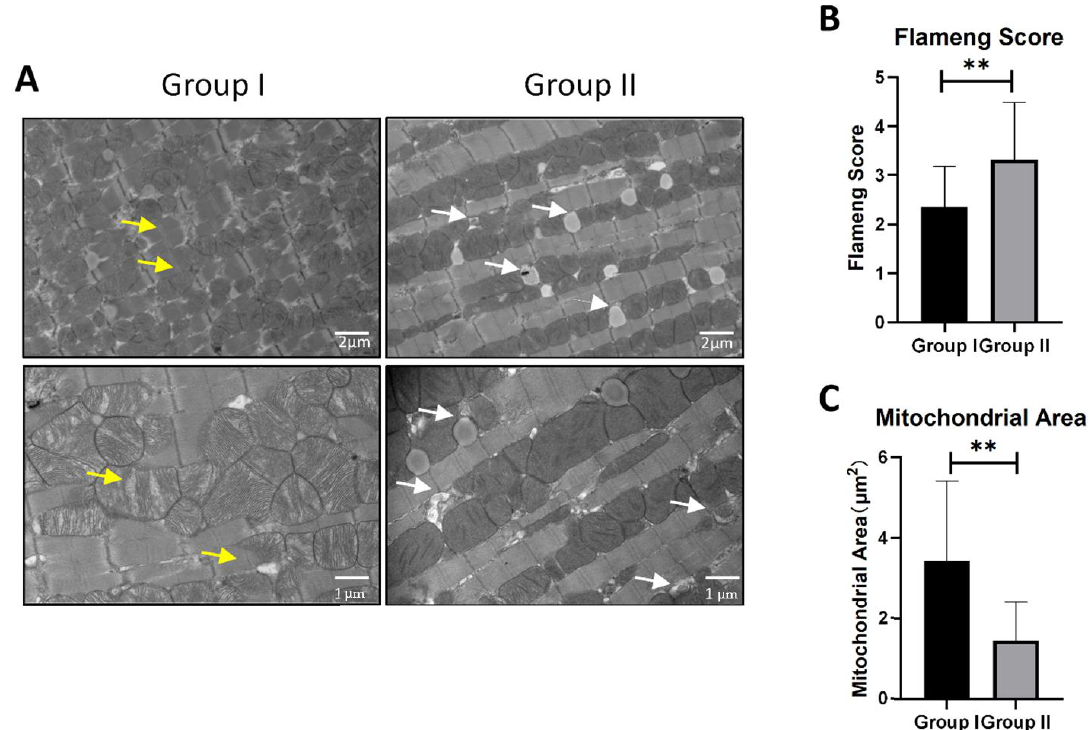
Figure 2. The effect of two surgical procedures on mitophagy induction after 6 h HTK preservation. ( A ) Ultrastructure changes under transmission electron microscope image of two groups. Yellow arrows show contraction bands and damaged mitochondria with matrix clearance and ruptured membrane. White arrows show mitophagy. Scale bars respectively indicate 2 µ m and 1 µ m. ( B ) Mitochondrial injury was measured by the Flameng score system ( n = 3). ( C ) Mitochondrial area was analyzed by Image J. At least 100 mitochondria from 5 randomly selected images were analyzed ( n = 3). ** p <